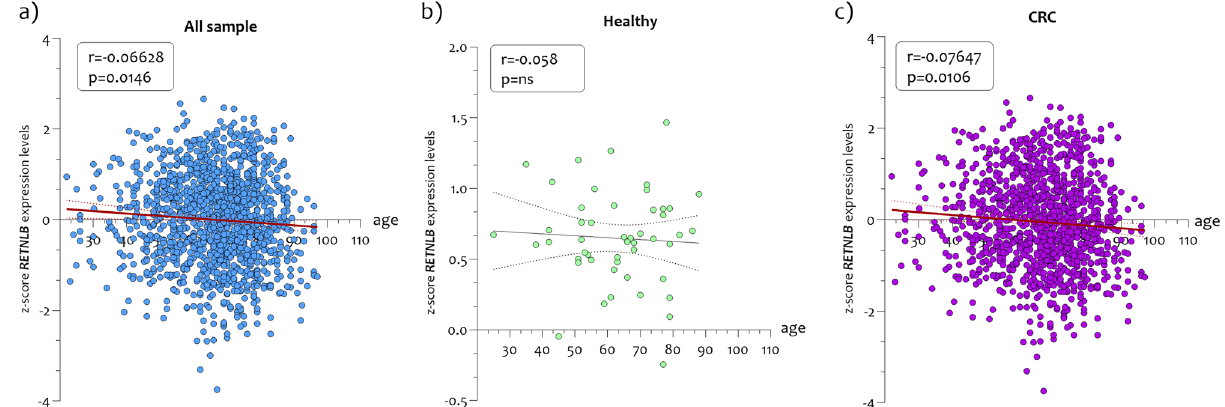
Figure 2. Inverse correlation between RETNLB levels and age in healthy and CRC patients’ biopsies . ( a ) Significant inverse correlation between RETNLB expression levels and age of all sample analyzed; ( b ) No significant correlation were observed between the RETNLB and age in healthy colon mucosa biopsies; ( c ) Significant correlation were observed between the RETNLB expression levels and age of patients affected by CRC. The dashed lines indicate the maximum and minimum mean values. Data are expressed as z-score intensity expression levels (means and SD) and presented as dot plots. p values < 0.05 were considered as statistically